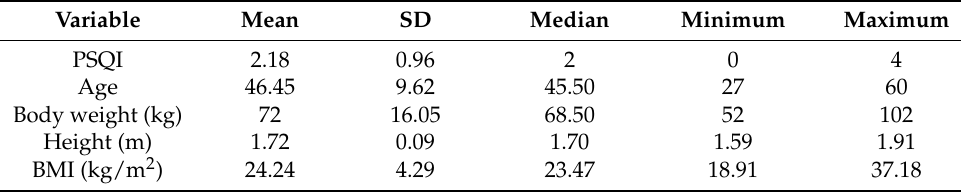
Table 1. Participant characteristics ( n = 22). PSQI, Pittsburgh Sleep Quality Index; SD, standard deviation; BMI, Body Mass Index. PSQI, body weight, height, and BMI were measured before the control night, the age was determined before the night shift.